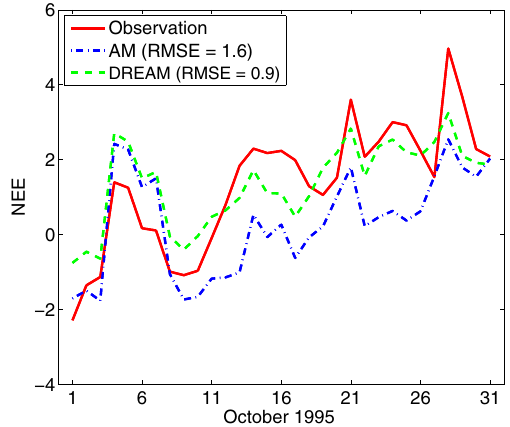
Figure 7. Simulated NEE values based on the optimal parameters (i.e., the MAP values listed in Table 1) estimated by the AM and DREAM algorithms in October 1995. The root mean square error (RMSE) indicates that DREAM produces a better model fit than